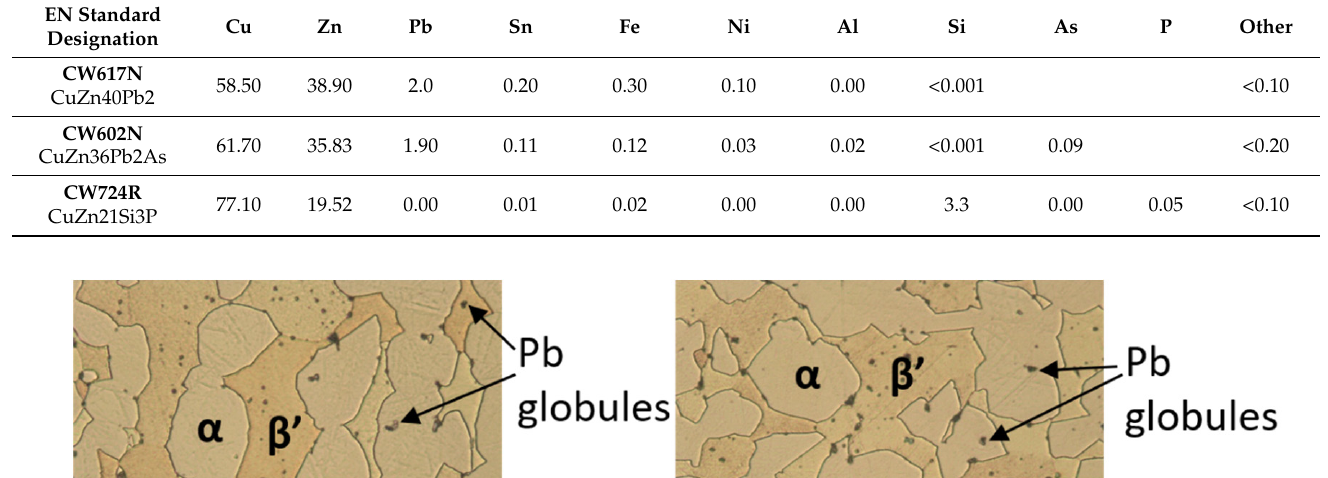
Table 1. UNI-EN specifications and GDOES compositions (as weight percentage) of the studied brasses.